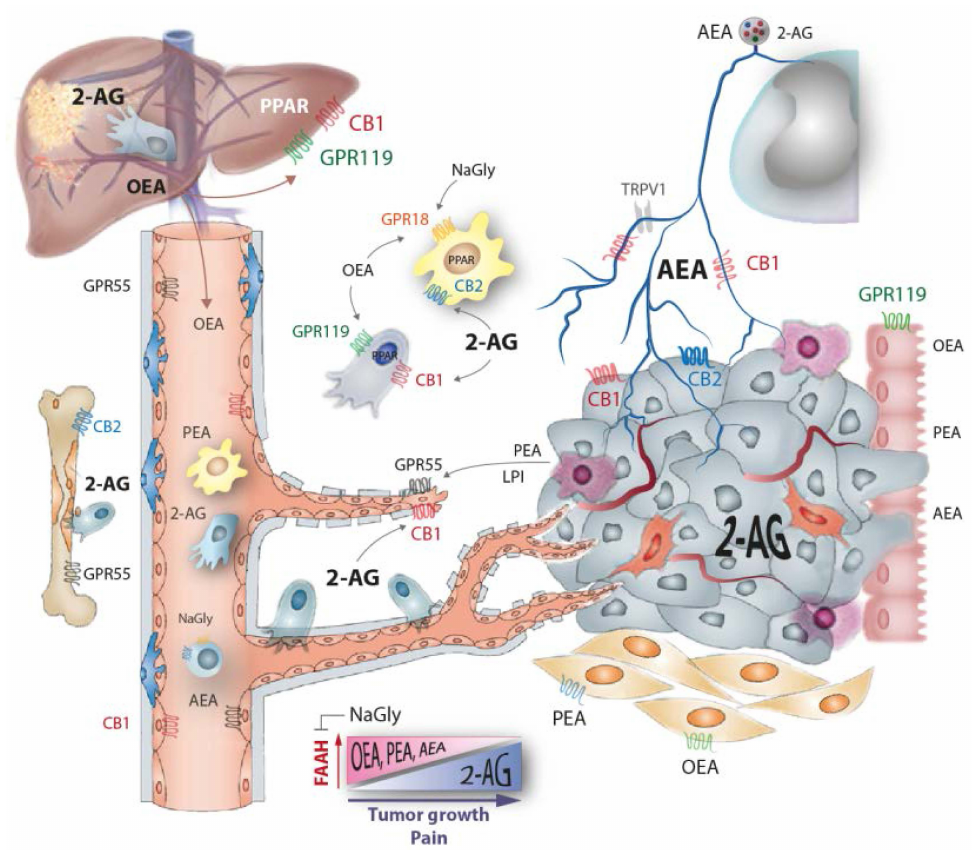
Figure 1. Tumor growth causes an increase of 2-arachidonoylethanolamide (2-AG) in tumor tissue and plasma and a decrease of ethanolamide endocannabinoids anandamide (AEA), oleoylethanolamide (OEA), palmitoylethanolamide (PEA) because the tumor displaces normal tissue and increases fatty acid amide hydrolase (FAAH) expression. It is likely that the tumor itself mainly secretes 2-AG. The endocannabinoids have diverse effects on cannabinoid receptors including the typical cannabinoid receptor 1 and 2 (CB1, CB2), the orphan G-protein coupled receptors (GPRs) 18, 55, 92 and 119 and peroxisome proliferator activated receptor (PPAR) gamma and alpha, and AEA also acts on transient receptor potential family V type 1 (TRPV1), resulting in complex regulation of tumor growth, metastasis, angiogenesis, polarization of tumor-associated macrophages and dendritic cells, T-cell activation and cancer pain. Treatment with exo- and endogenous cannabinoids reduced cancer growth in several rodent models and cell culture experiments [25–31], but CB2 expression of the tumor itself has been recently associated with poor prognosis in breast cancer